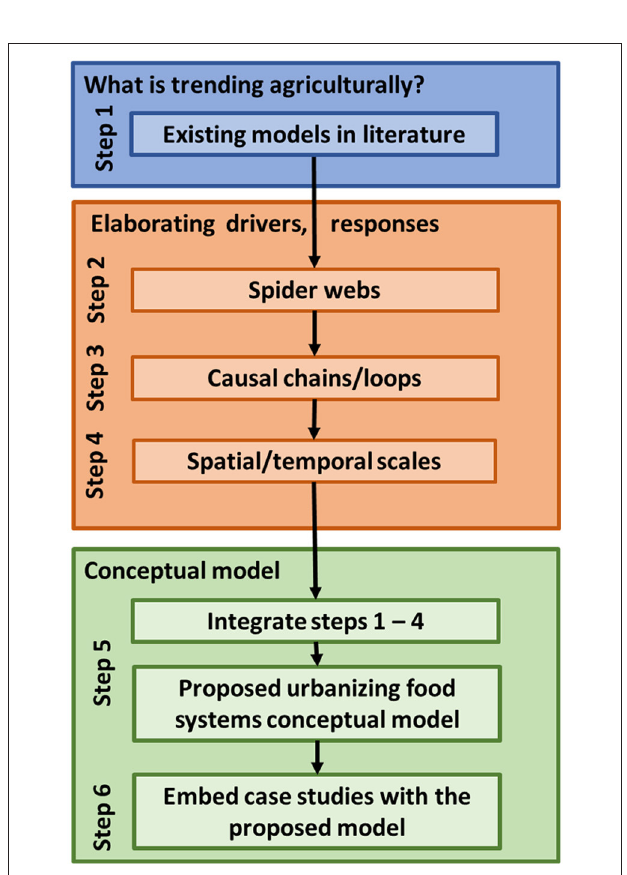
FIGURE 2 | Schematic of methodology followed in the